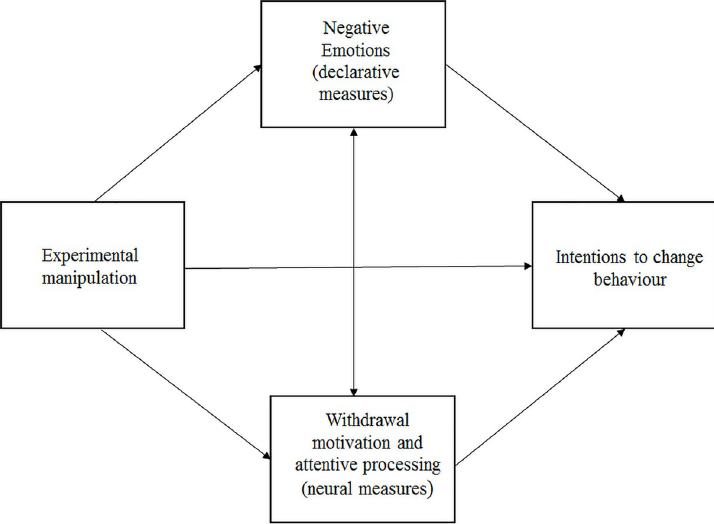
Fig 1. Theoretical model of the relationship between experimental manipulation and intention to change behavior via declarative and neural attitudes toward a social campaign.